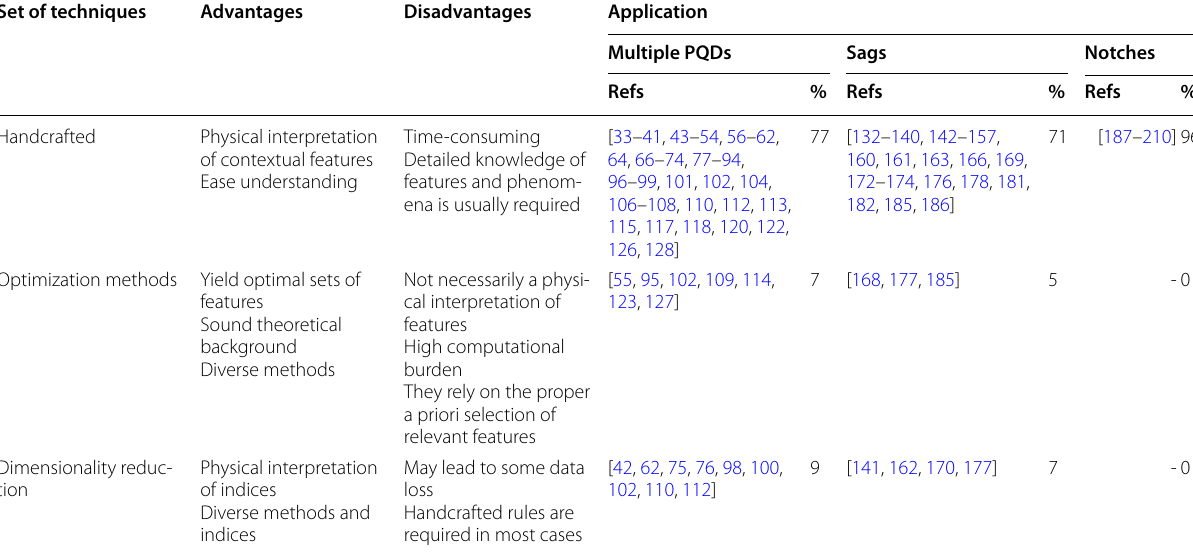
Table 10 Summary of feature selection techniques Set of